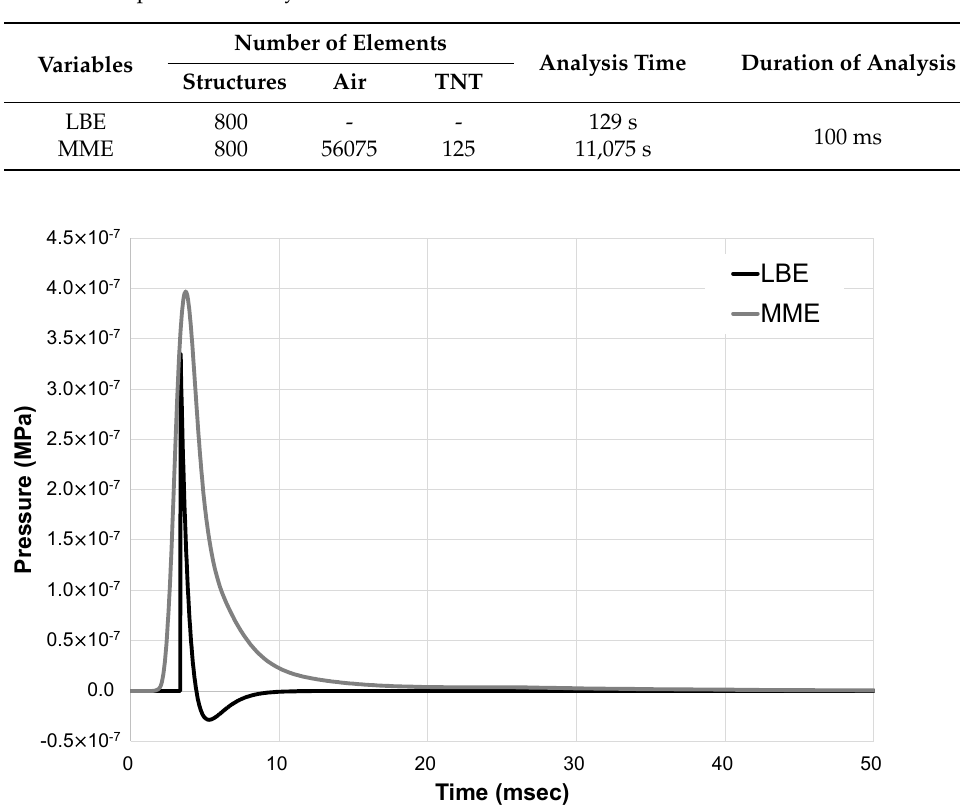
Table 1. Comparison of analysis time of MME and LBE.